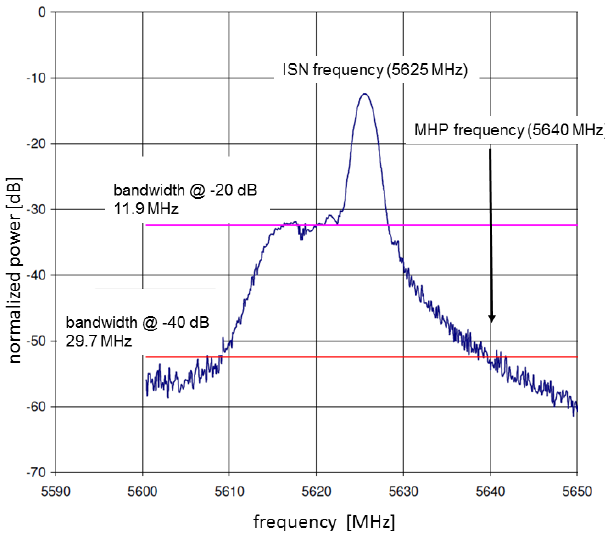
Figure 10. Measured frequency spectrum of the ISN magnetron for a pulse length of 0.4µs. Measurements were taken between the magnetron and the wave guide filters. The resulting bandwidths at − 20 and − 40dB are shown. The ISN transmitter is operated at 5625MHz. For illustrative purposes, the MHP transmitter fre- quency (5640MHz) is shown as